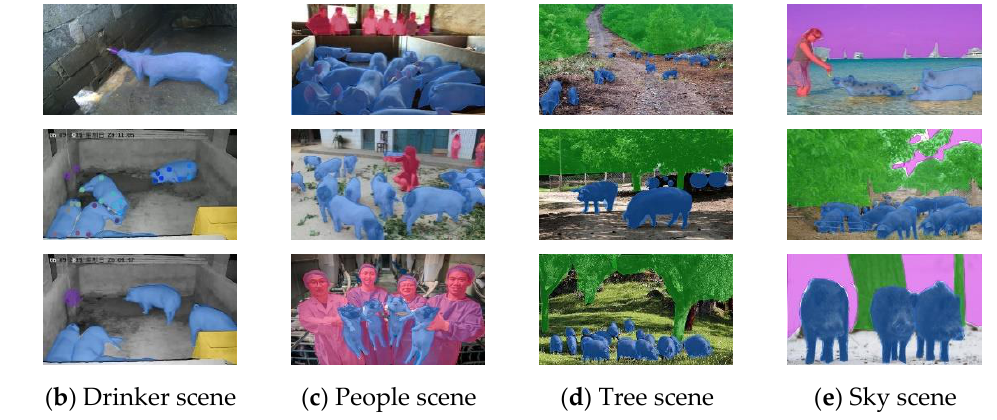
Figure 11. Segmentation results of different scenes. Table 1. Segmentation results of the different